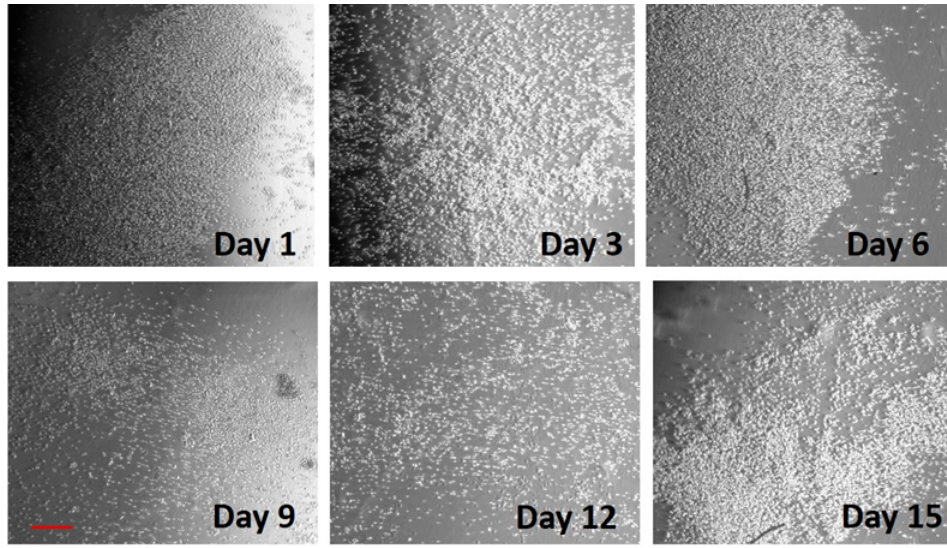
Figure 7. Panoramic view of membrane-engineered cells cultured in the hydrogel matrix after incubation for 15 days. Pictures were taken every 3 days. Scale bars = 50 µ m.